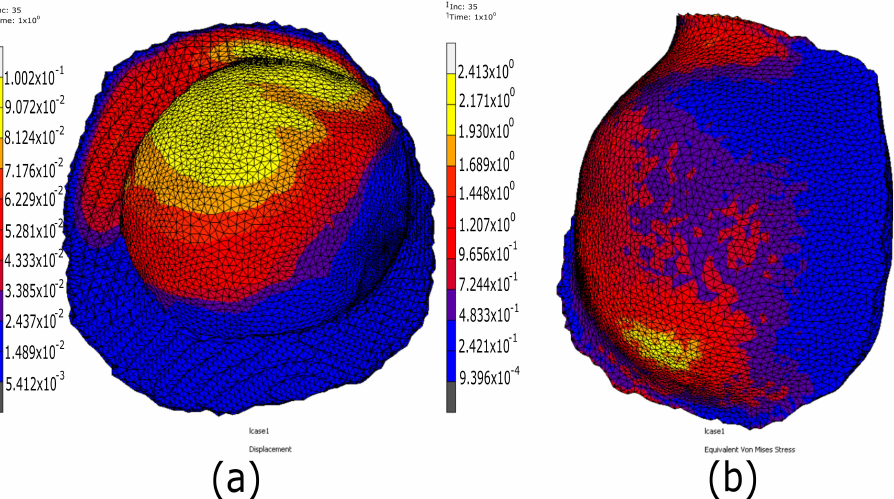
Figure 7. FE results for the cartilage of the healthy hip joint: ( a ) displacement and ( b ) von Mises stresses.